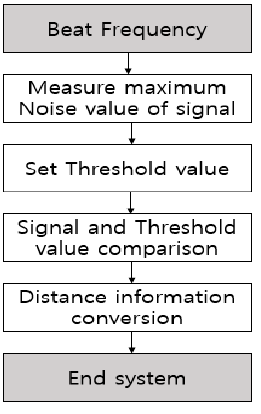
Figure 4. Flow Chart of ST-CFAR Algorithm.